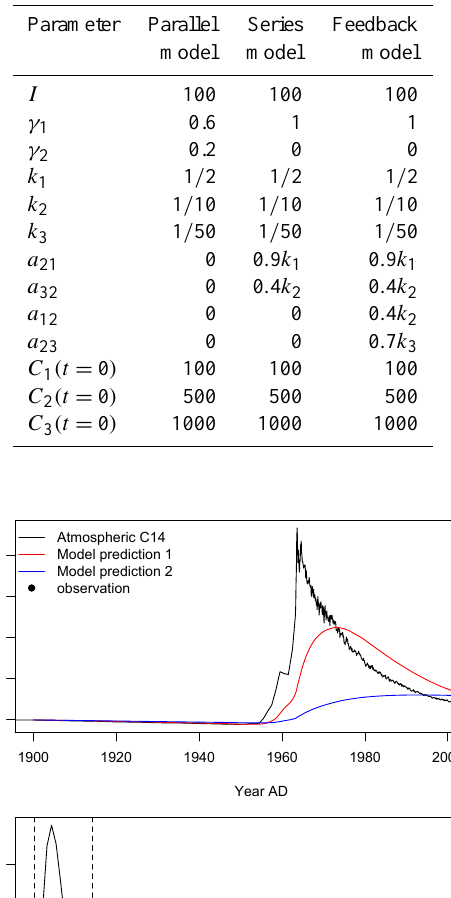
Table 2. Parameter values and initial conditions used to simulate a three-pool model with different structures as represented in Fig. 1 and Eqs. (18)–(20).